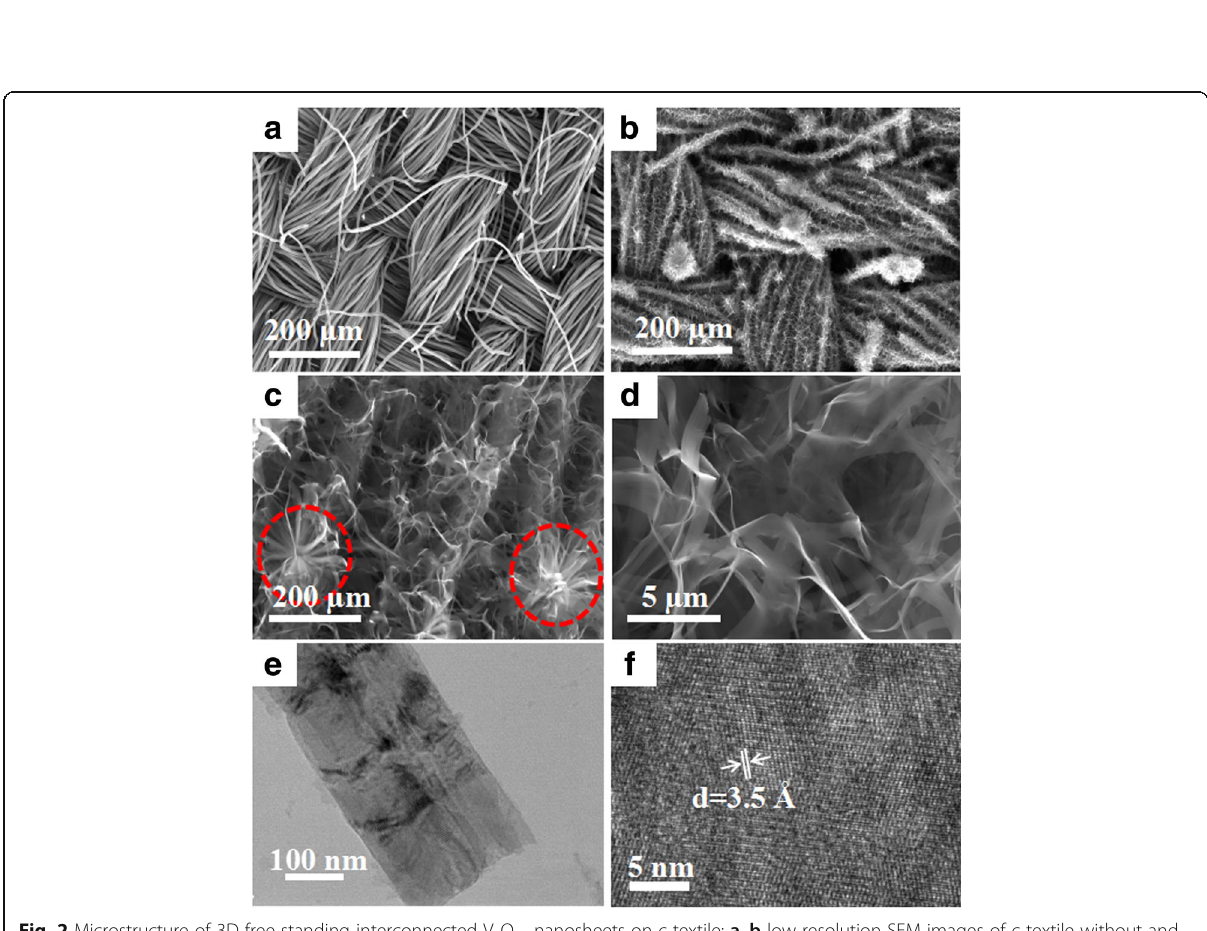
Fig. 1 Optical images of a commercially available textile, b carbonized textile, c rolled and twisted c-textile, and d c-textile with grown V 6 O 13 at the rolled state, inset: at the flat state